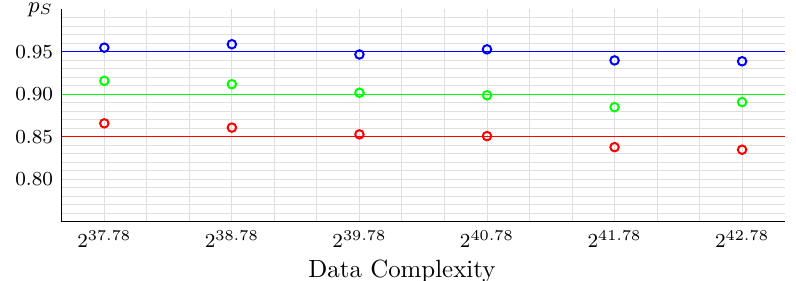
Figure 6: Experimental Success Probability